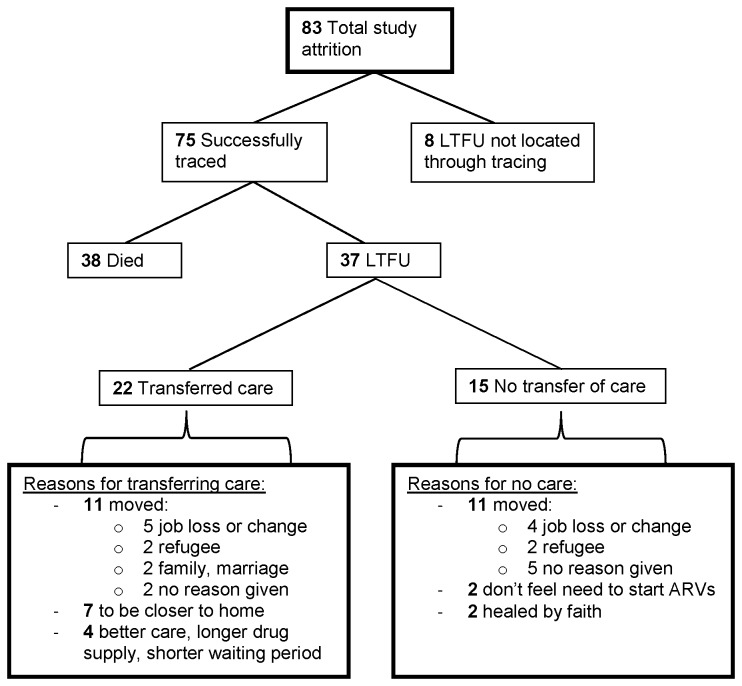
Attrition outcomes and reasons for loss.